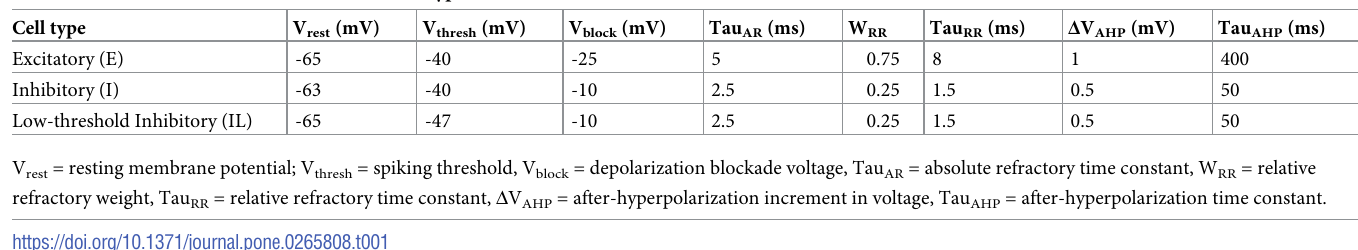
Table 1. Parameters of the neuron model for each